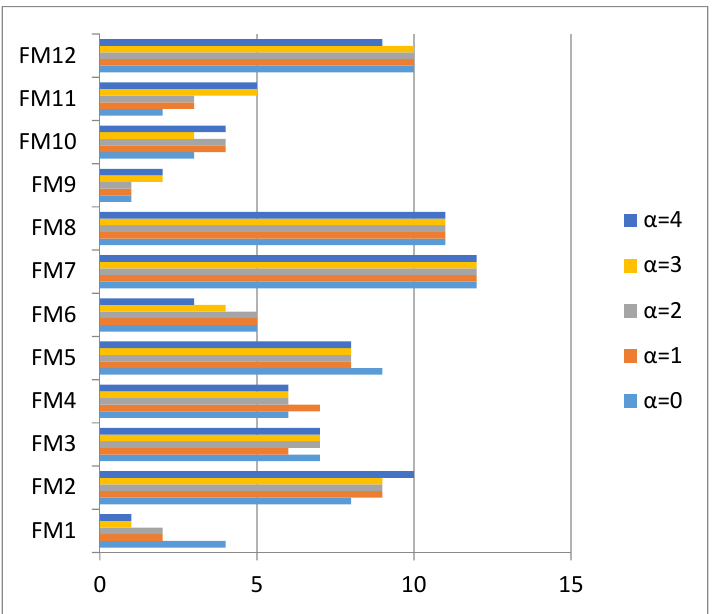
Figure 6. Ranking comparison of taking different α value (improved fuzzy TOPSIS using subjective-variable integrated weight method).